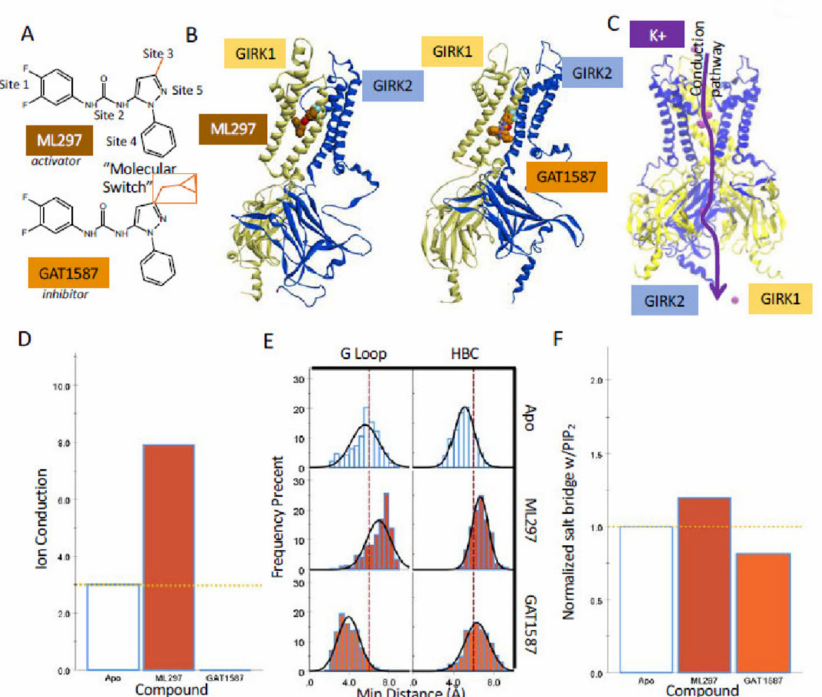
Figure 1. Pharmacological actions of a molecular switch moiety are reproduced in sub-microsecond MD simulations in GIRK1/2. ( A ) The structures of GIRK1 specific modulators ML297, GAT1587, and the site of molecular switching region (off the pyrazole ring) that controls compound activity. ( B ) Equilibrium binding site for ML297 and GAT1587 following a 300 ns stochastic dynamics simula- tion in complex with PIP 2 and GIRK1/2. ( C ) Ion permeation pathway for a single ion taken from the ML297-PIP2-GIRK1/2 simulation. ( D – F ) Ions conducted, minimum gate distances, and normalized salt-bridge formation over the last 150 ns of the simulations are